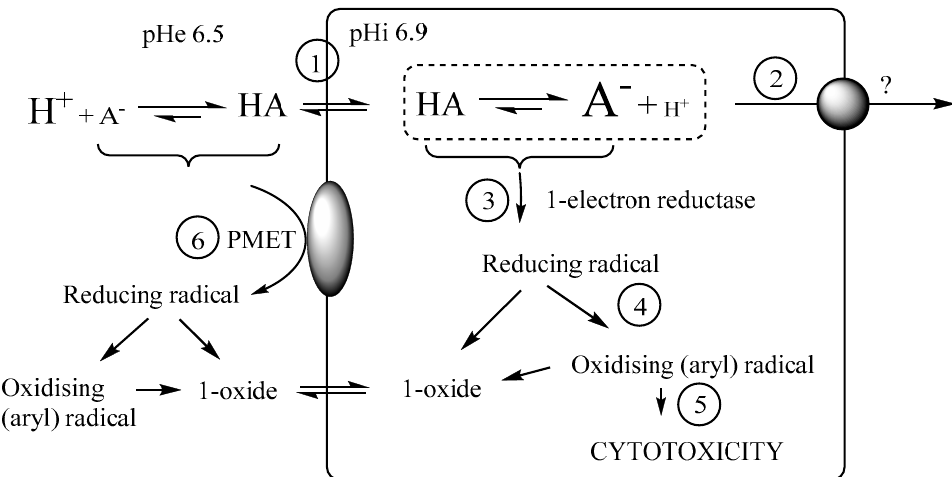
Figure 9. Model for the cellular pharmacology of BTO acids (HA). Extracellular acidification when pHe is reduced from 7.4 to 6.5 leads to a smaller change in pHi (from 7.3 to 6.9), reversing the pH gradient across the plasma membrane and resulting in increased intracellular entrapment as the membrane-impermeable anion (1). This pH-dependent partitioning provides selective uptake and cytotoxicity at a low pHe, but intracellular concentrations of the BTO acids are lower than extracellular, even at pHe 6.5, possibly reflecting the activity of unidentified e ffl ux pump(s) (2) or that equilibrium is not reached during the 4 h exposures to these hydrophilic compounds. Under hypoxia, the intracellular drug is metabolized by one-electron reduction (3) to a radical that can either be reduced further to the sTable 1-oxide metabolite or generate a strongly-oxidizing aryl radical (4) which induces DNA damage and cytotoxicity (5). Oxygen-inhibited reductive metabolism also occurs at the cell surface, potentially by the plasma membrane electron transport (PMET) system (6) or other cell surface one-electron reductases, such as STEAP4. However, extracellularly generated radicals cannot access the presumed intracellular targets responsible for cytotoxicity and thus represent ‘wasted’